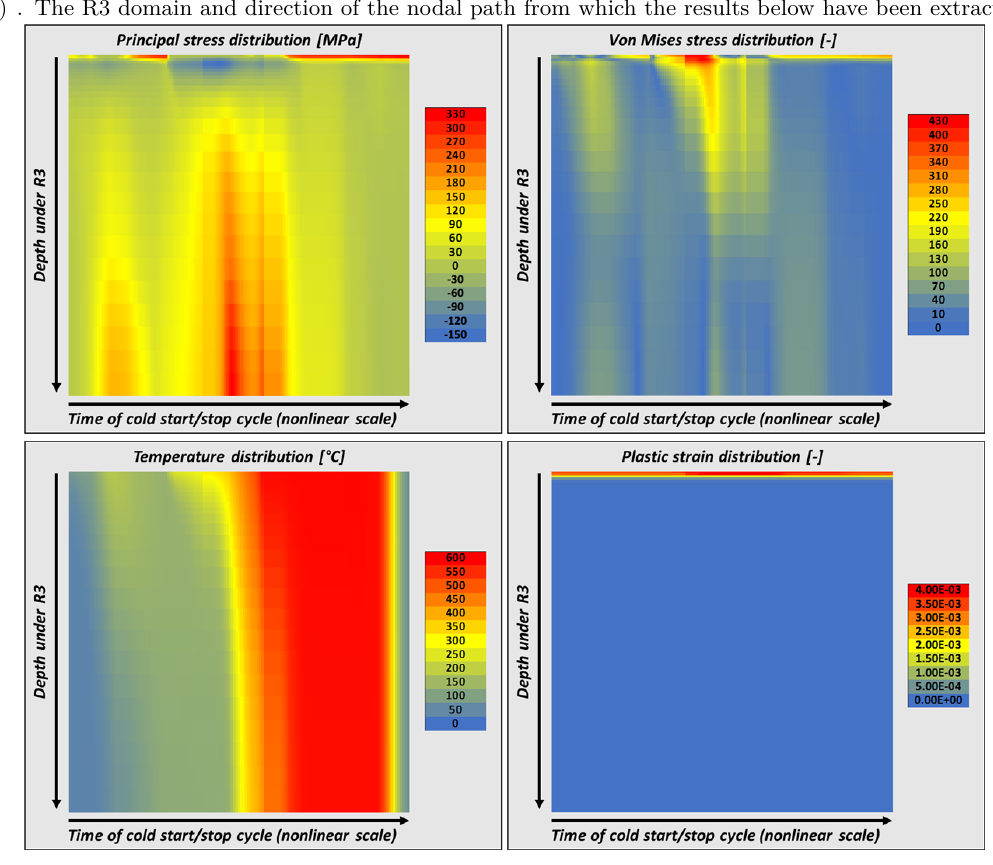
Figure 10. FEA results in the R3 domain of the sample steam turbine shaft.